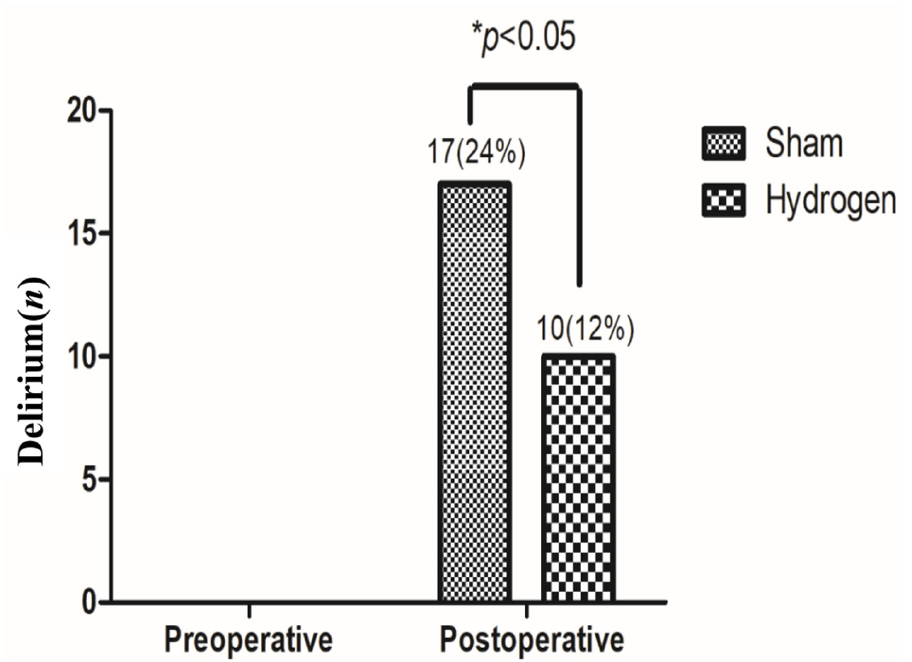
Figure 2. Number and percentage of diagnosed delirium pre-operatively and postoperatively in the two groups. For statistical significance, * indicates p ≤ 0.05. Table 3. Effectiveness outcomes.